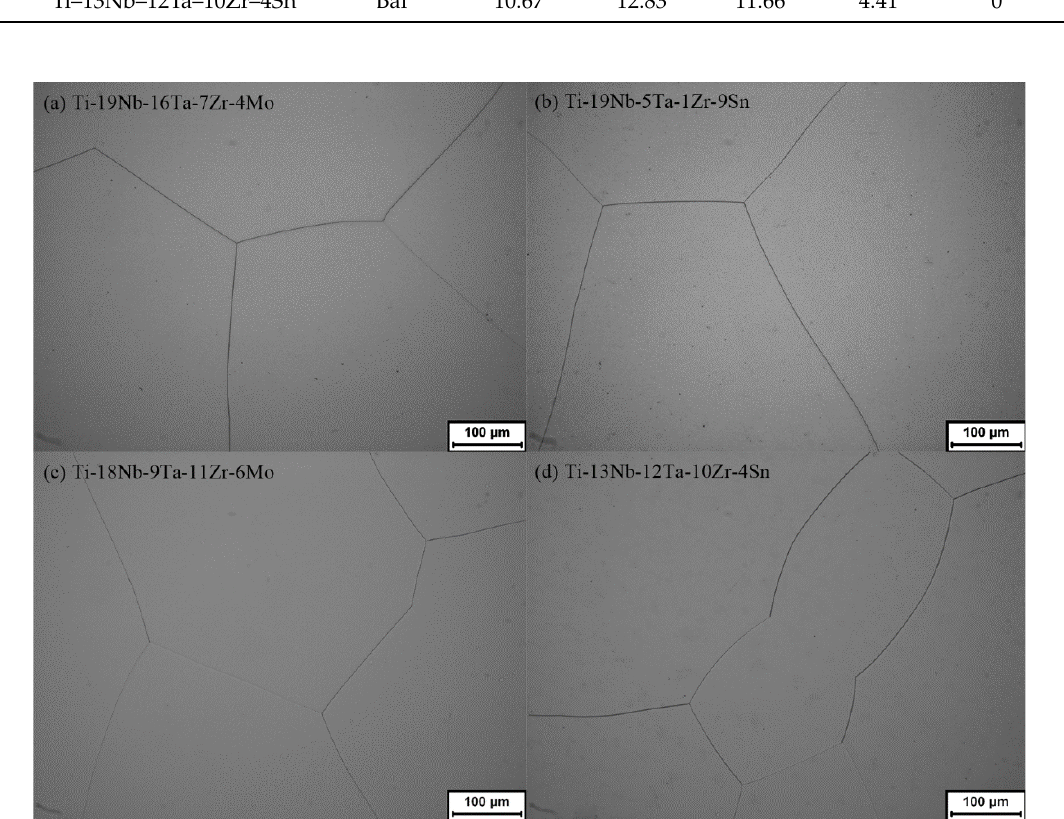
Figure 7. Microstructures of the Ti – Mo – Nb – Ta – Zr – Sn alloys were observed by optical microscope after water quenching: ( a ) Ti – 19Nb – 16Ta – 7Zr – 4Mo, ( b ) Ti – 19Nb – 5Ta – 1Zr – 9Sn, ( c ) Ti – 18Nb – 9Ta – 11Zr – 6Mo, and ( d ) Ti – 13Nb – 12Ta – 10Zr – 4Sn.